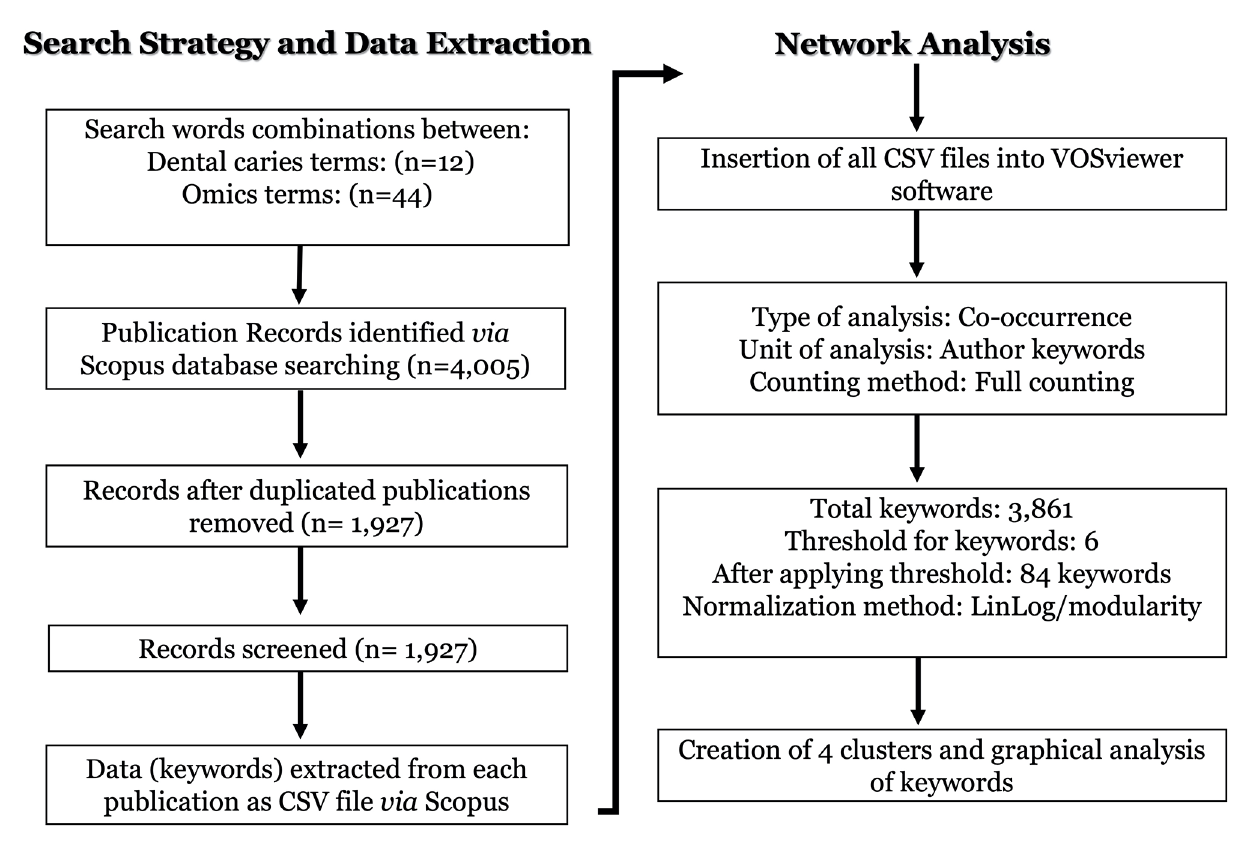
FIGURE 3 | Flowchart of the search strategy, data extraction and networking analysis of the omics studies in dental caries research. The dental caries literature was screened on Novermebr1st, 2021 via Elsevier ’ s Scopus database. The search terms were identi fi ed to cover dental caries terms (n = 12) in combination with omics- related terms (n = 44) in either the article title and/or the abstract and/or the authors keywords as detailed in ( Table 1 ). All search output fi les of identi fi ed publications (n = 4,005) were downloaded from the Scopus, concatenated, and duplicate entries were excluded. Deduplicated papers (n = 1,927) were imported to the Visualization of Similarities (VOSviewer) software for descriptive exploration and co-occurrence network analysis as described in the fl owchart under the “ network analysis ”